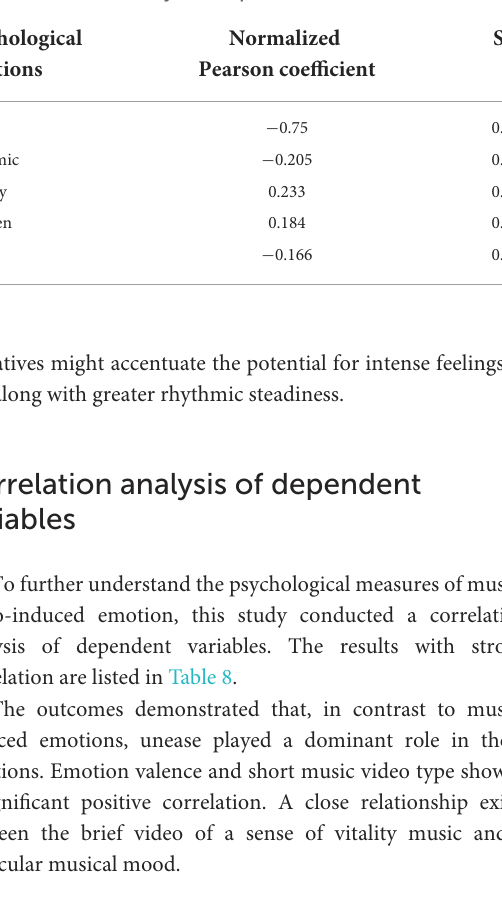
TABLE 8 Correlation analysis of dependent variables. TABLE 9 Hypothesis testing